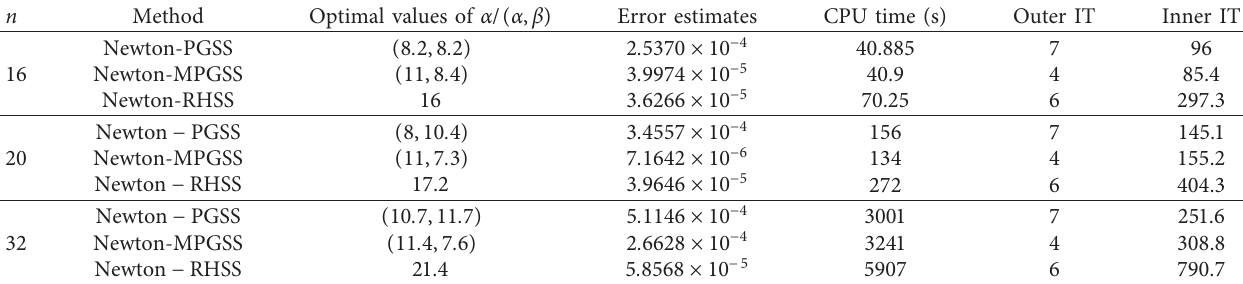
Table 6: Numerical results of inexact methods for v � 1 and η �